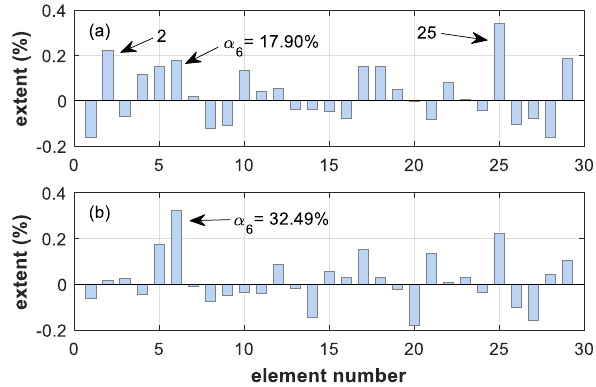
Figure 3. The damage identification results of damage case A at a 3% level of noise, with the least- squares solution: ( a ) CMSE method; ( b ) RCMSE method. solution: ( a ) CMSE method; ( b ) RCMSE method.